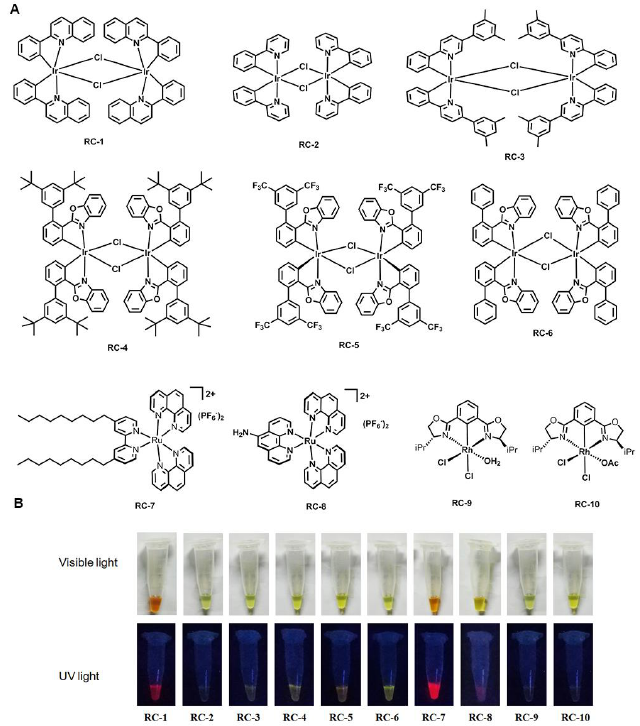
Figure 1. Chemical structures ( A ) and fluorescence characteristics of the RCs (RC-1~10). ( B ). The upper is the structures of RCs, and the below is the fluorescence of the RCs under visible or UV